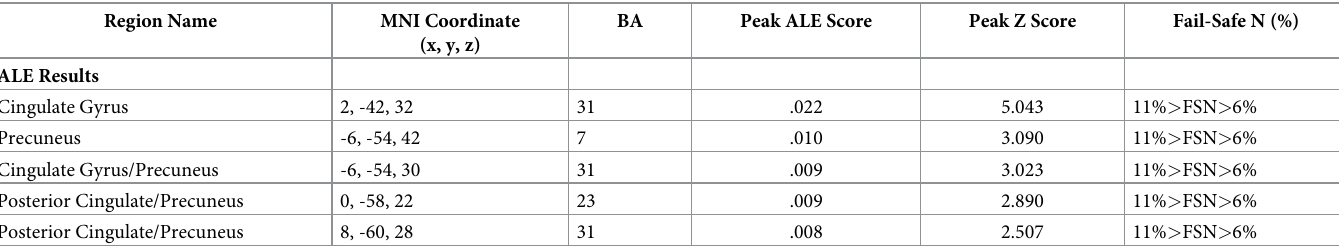
Table 2. Identified regions from corrected